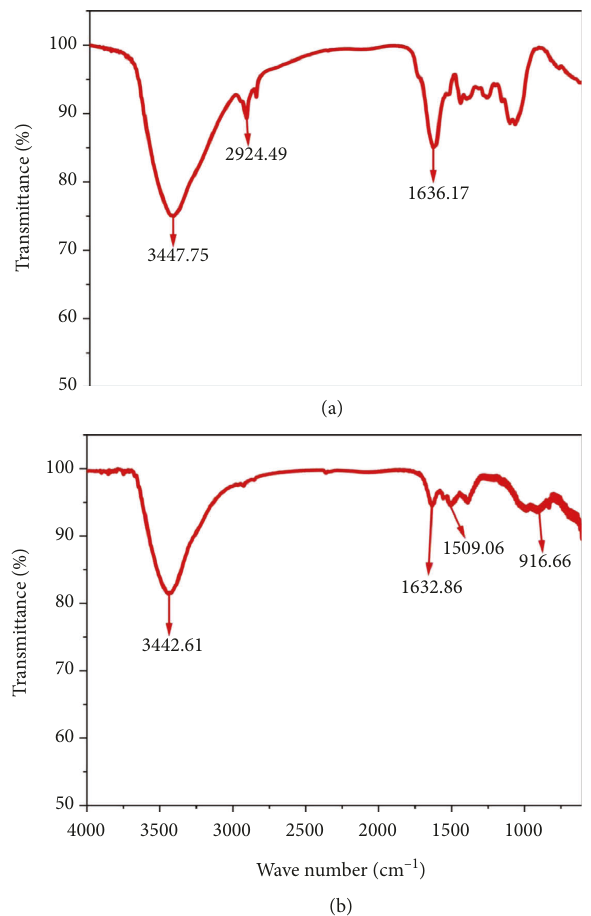
Figure 6: FTIR spectra of (a) zinc oxide nanoparticles (ZnONPs) and (b) plant-fabricated zinc oxide nanoparticles